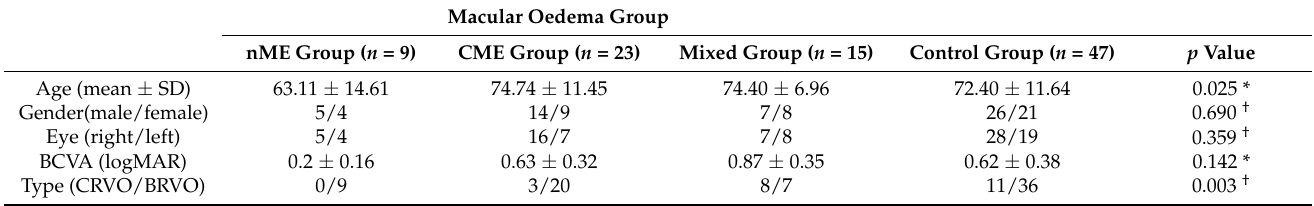
Table 2. Demographics and clinical features according to type of macular oedema in subjects with recent-onset central or branch retinal vein